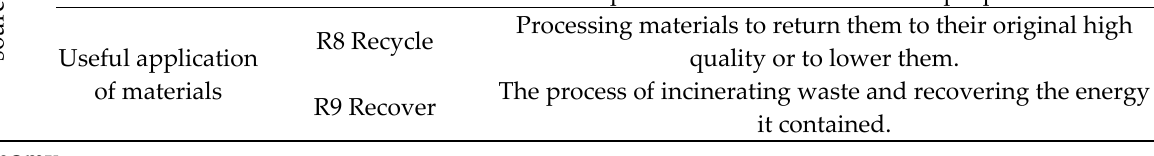
Figure 1. The 9R model, adapted from (Liu et al. 2022a).